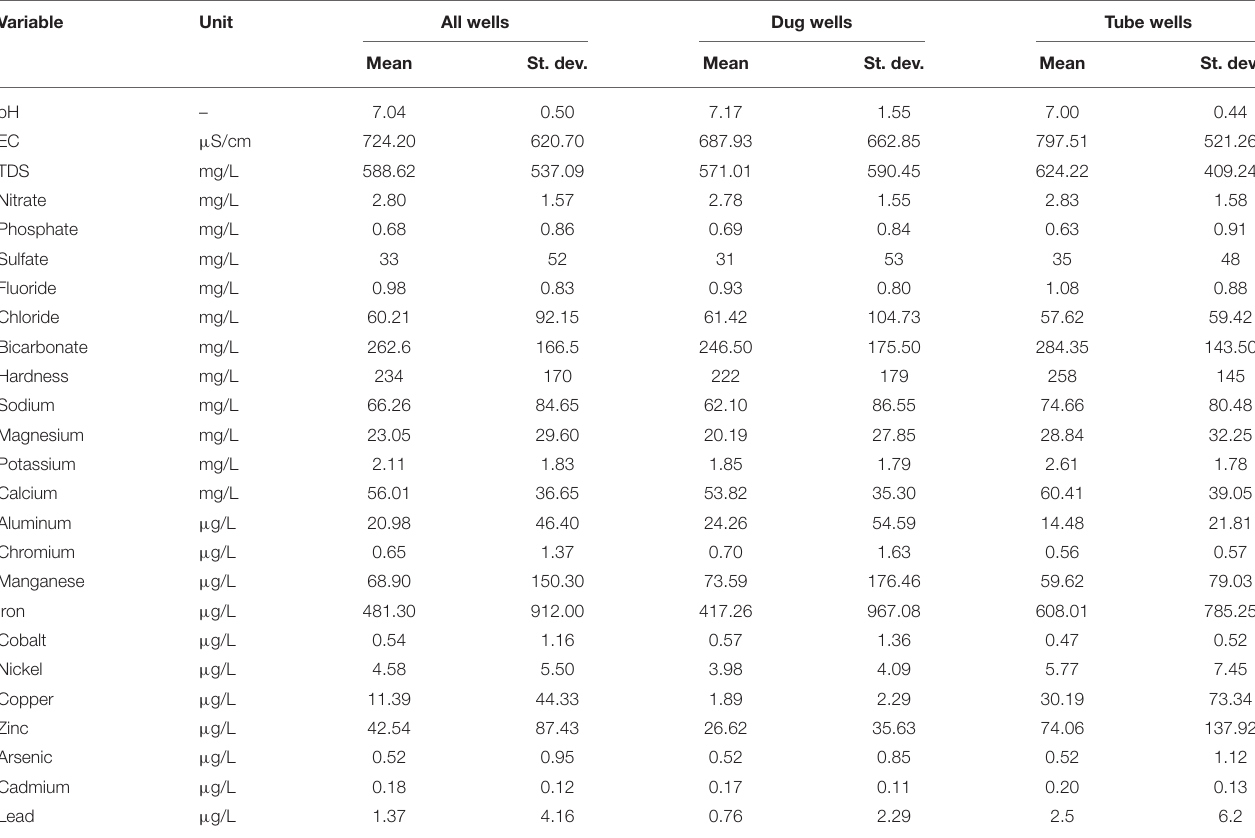
TABLE 2 | Descriptive statistics of the water quality parameters of the study